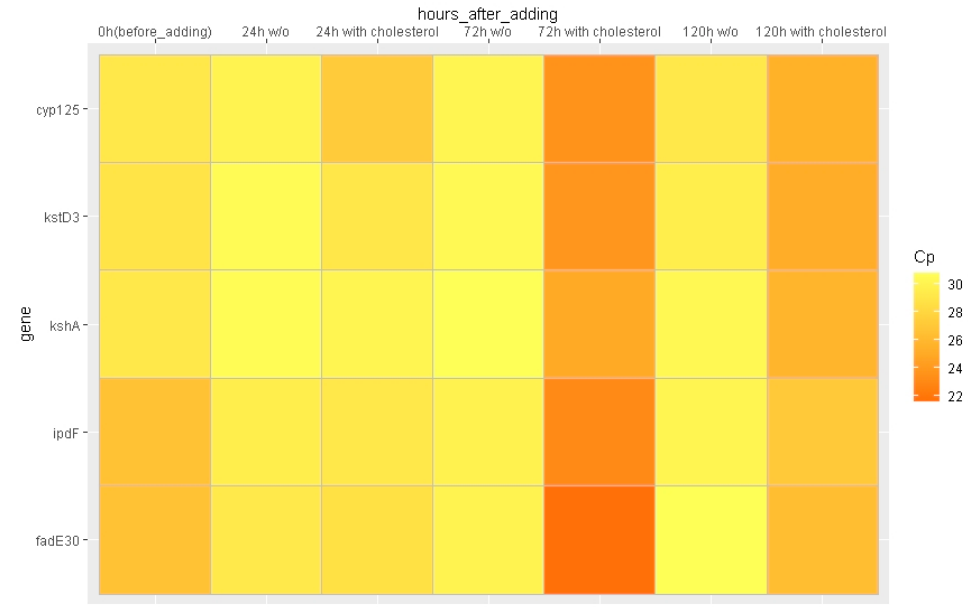
Figure 6. Heat map. The X-axis represents the sampling time for control and variant with cholesterol; the Y-axis represents the genes of interest. Crossing point (Cp) shows the cycle number for each gene of interest as normalized to the Cp of the 16S rRNA. Lower Cp values (higher expression) are brighter colors.